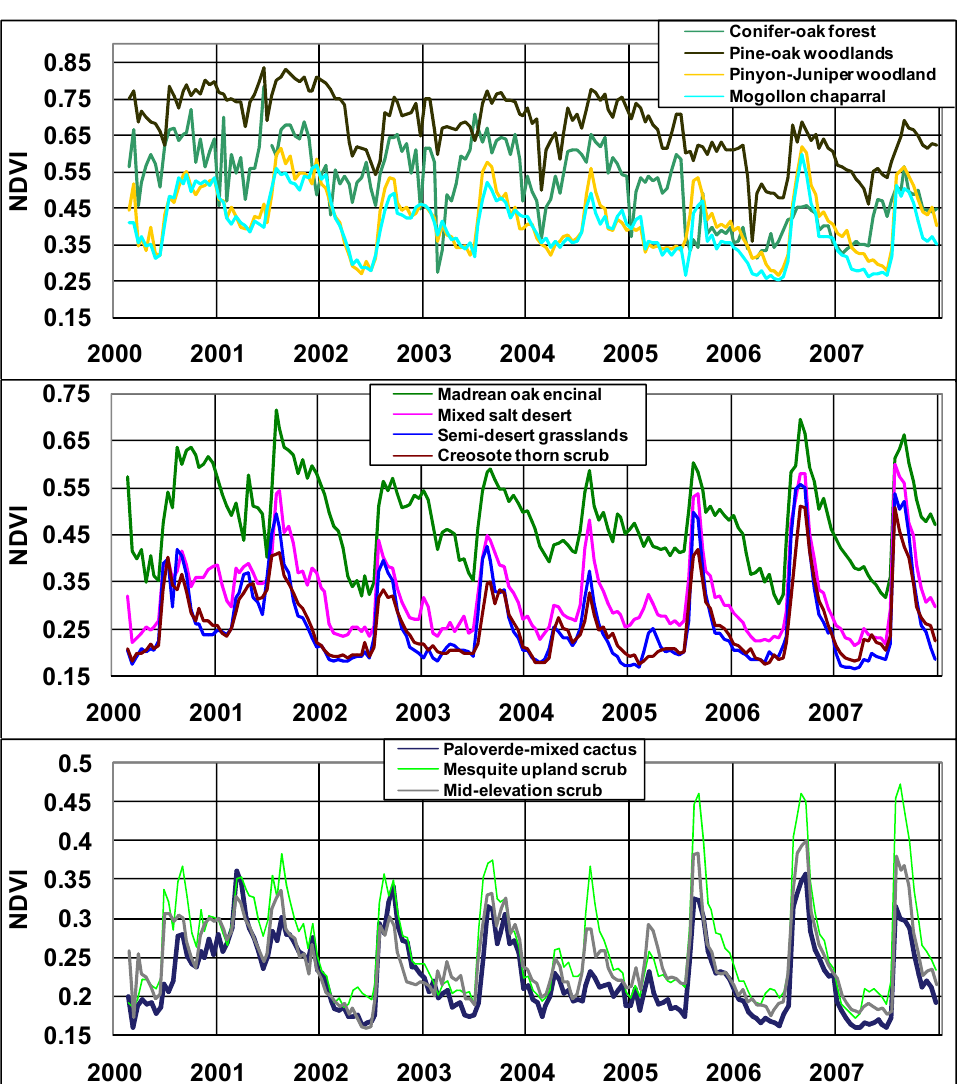
Figure 5. Average NDVI trajectories for each vegetation type, 2000–2007, Santa Rita Mountains, AZ, USA. Trends in magnitude, timing, and shape of NDVI are different for each vegetation type and each year. A high elevation forest fire in 2005 is the reason for the marked decreases in NDVI values for Conifer-oak forest and the somewhat lower NDVI values for the Pine-oak